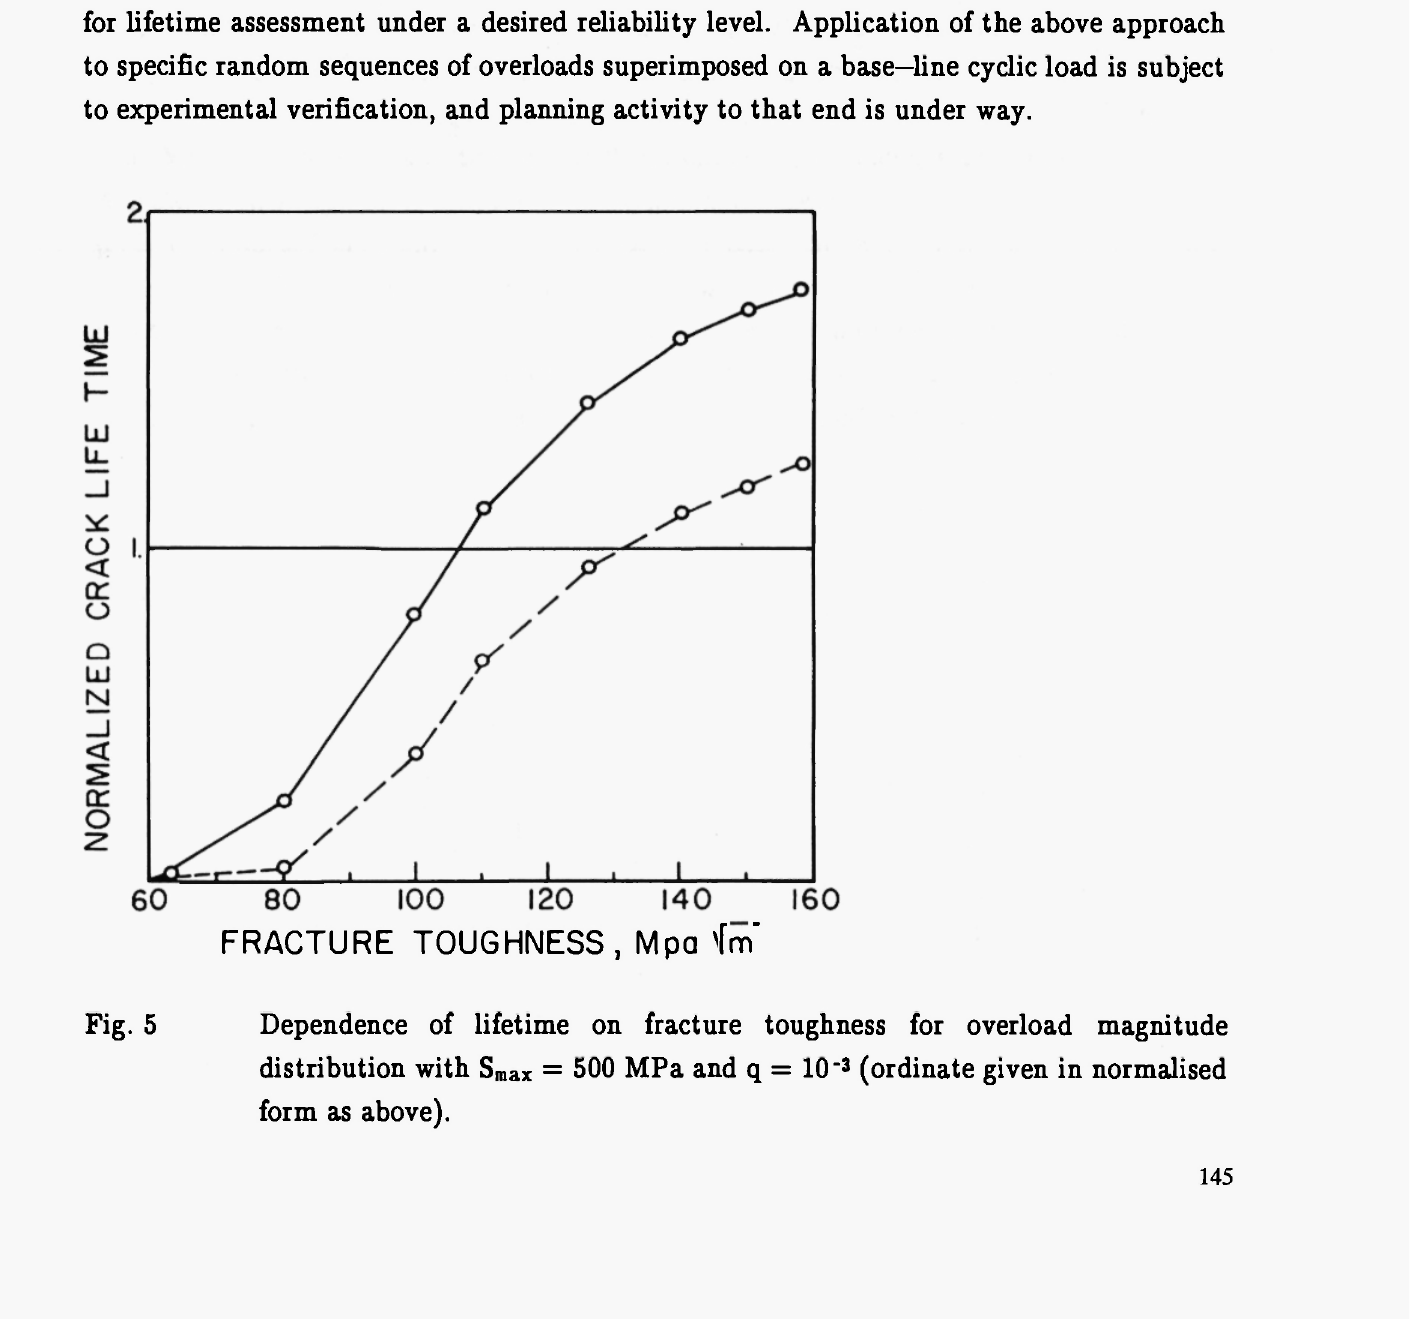
Fig. 5 Dependence of lifetime on fracture toughness for overload magnitude distribution with S = 500 MPa and q = 10" 3 (ordinate given in normalised raax form as